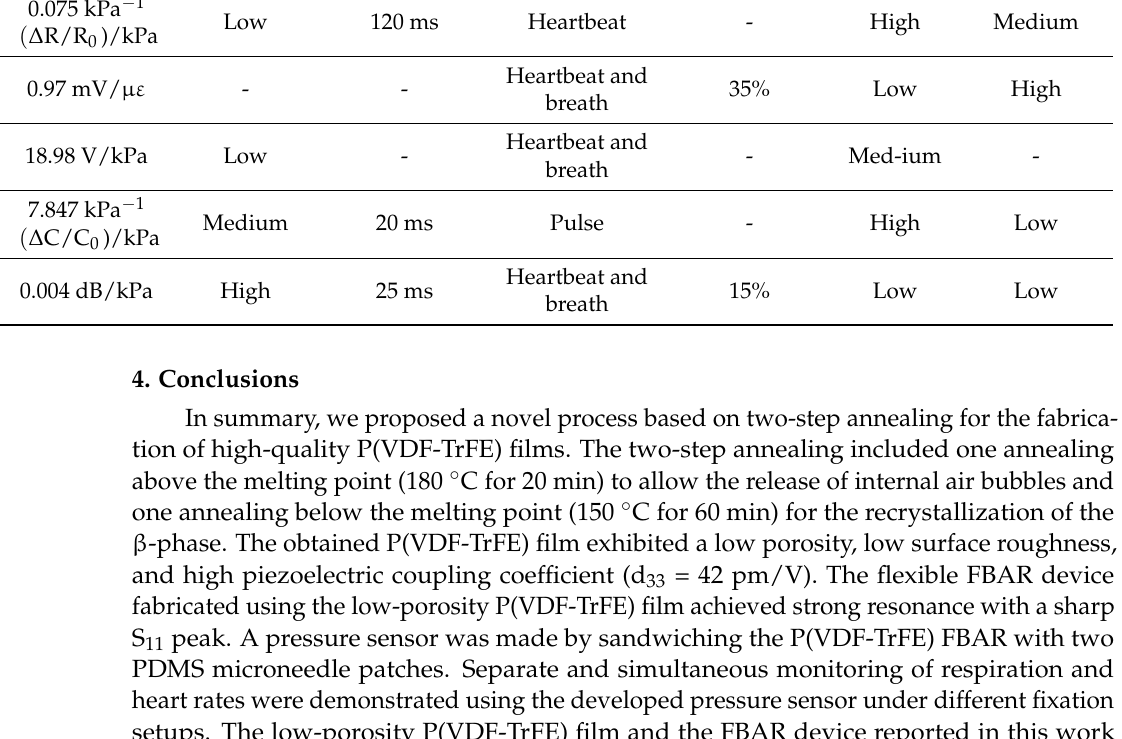
Figure S3: Image of the test system